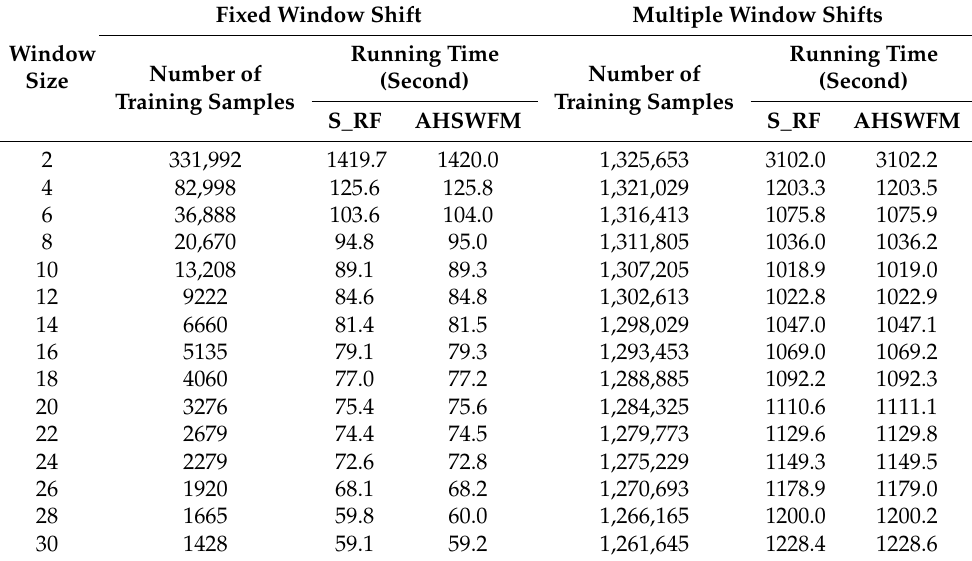
Table 2. Number of training samples and mean running time over two years of self-trained random forest regression (S_RF) and automated and hierarchical surface water fraction mapping (AHSWFM) using different window sizes and shifts in the aggregation to coarse pixel samples in the water fraction